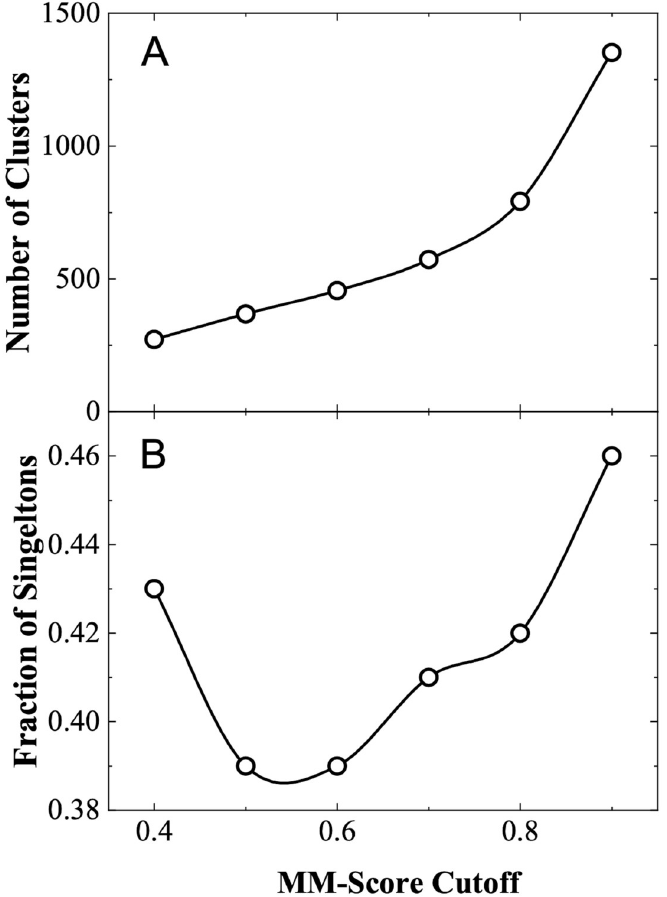
Fig 1. Analysis of structure clusters at different clustering cutoffs. The number of clusters produced at each clustering cutoff (A) grows monotonously, providing no clear indication of the optimal clustering cutoff. The frequency of single complex clusters has a distinct minimum, suggesting MM-score 0.6 as the optimal